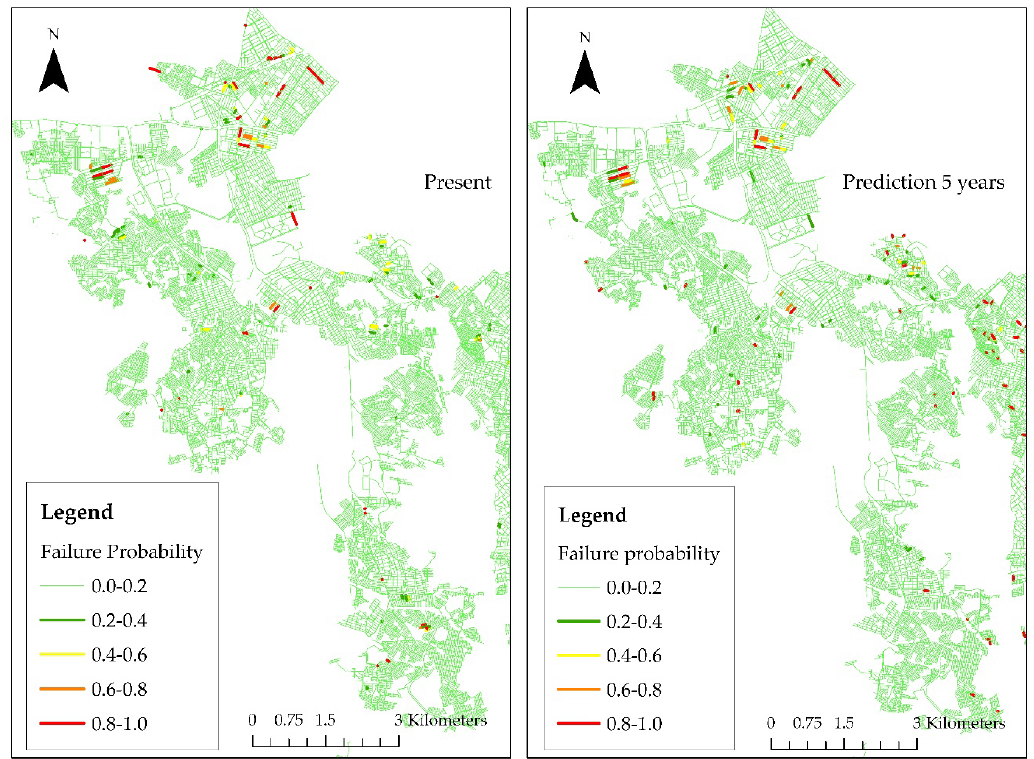
Figure 9. Predictions of the failure probability in asbestos-cement and PVC pipes.